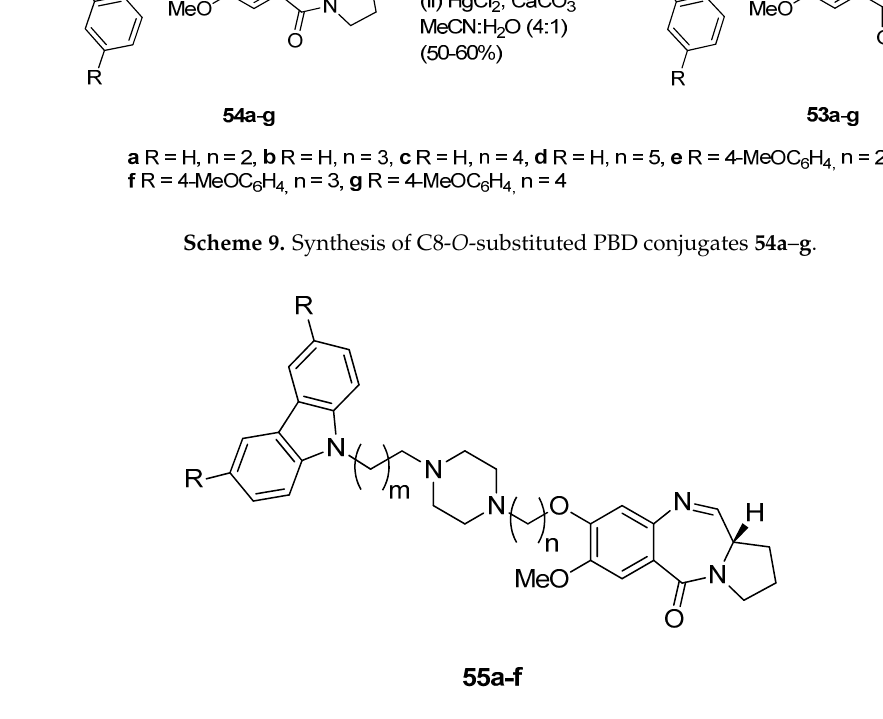
Figure 4. C8- O -substituted PBD conjugates 55a – f .